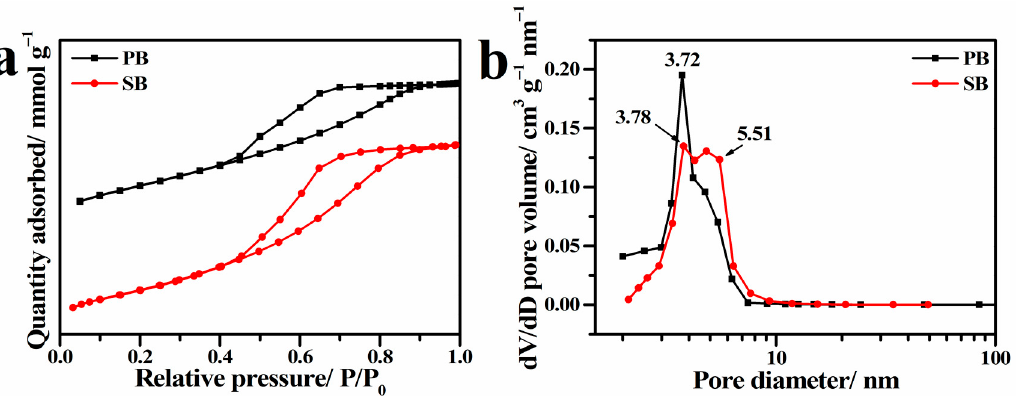
Figure 3. Low-temperature nitrogen adsorption isotherms ( a ) and corresponding pore size distribu- tion curves ( b ) of PB and SB samples.